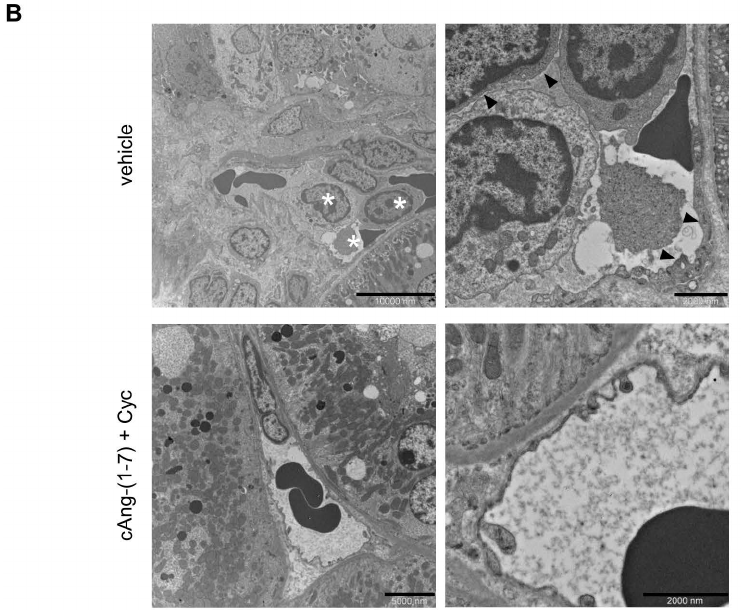
Figure 6. Addition of cAng-(1-7) to cyclophosphamide ameliorates tubulo-interstitial abnormalities in rats with ANCA-GN. ( A ) Representative images of Masson’s trichrome-stained kidney sections from WKY rats with ANCA-GN treated with vehicle and cAng-(1-7) plus cyclophosphamide: left panels, tubulointerstitial alterations consisting of tubular casts, tubular dilatation and atrophy in vehicle-treated group limited by the combined therapy ( × 400 Magnification; scale bar 20 µ m); right panels, dilated peritubular capillaries (asterisks) with inflammatory cells (capillaritis) in vehicle- treated group prevented in rats that received cAng-(1-7) plus cyclophosphamide ( × 630 Magnification; scale bar 20 µ m). ( B ) Representative micrographs from transmission electron microscopy of interstitial area in vehicle group and cAng-(1-7) plus cyclophosphamide group: left panel, accumulation of inflammatory cells (asterisk) in peritubular capillaries of vehicle-treated group abolished by the combined therapy; right panel, swelling of endothelial cells and loss of fenestrations (arrowheads) in WKY rats given vehicle and preserved peritubular endothelial compartment in WKY rats treated with the combined therapy. Scale bars: 10,000, 2000, 5000, 2000